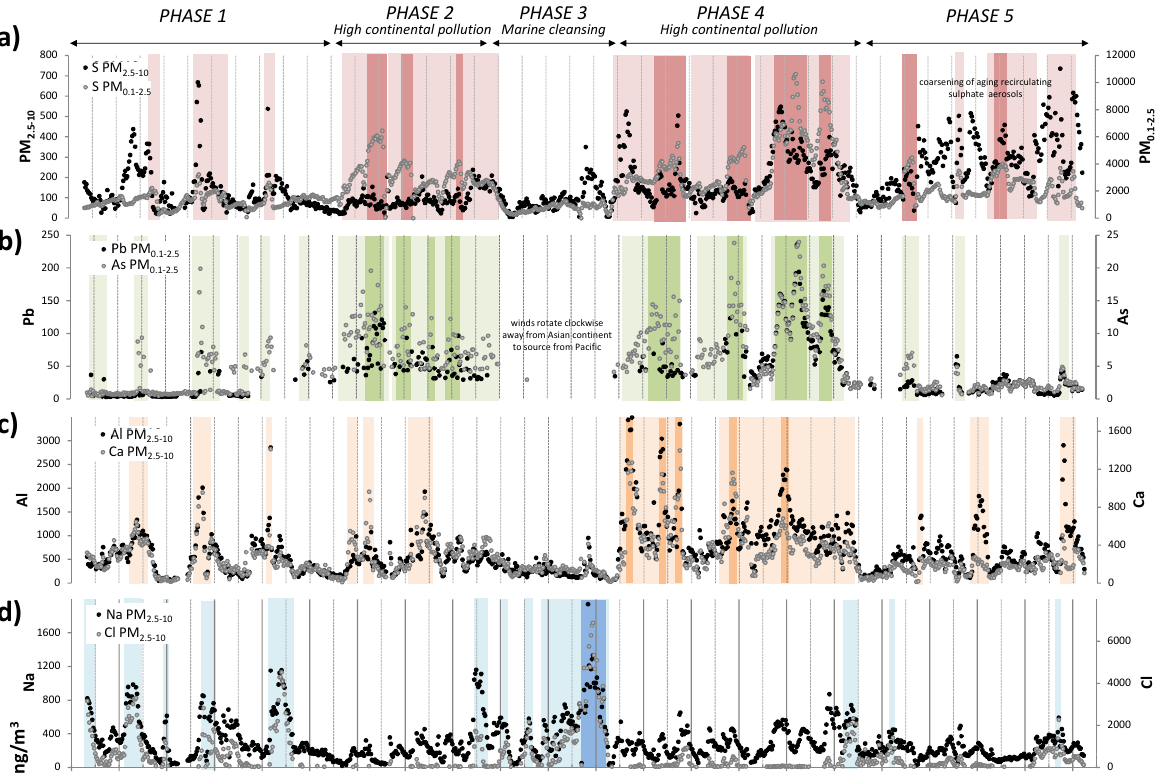
Fig. 4. Hourly selected elemental concentrations (ngm − 3 ) obtained with the Streaker sampler for the five air quality phases identified during the monitoring campaign, with coloured bands highlighting main episodes of continental pollution and advection of salty marine air across Kumamoto. (a) shows both coarse (PM 2 . 5 − 10 ) and fine (PM 0 . 1 − 2 . 5 ) sulphatic aerosol intrusions, (b) uses Pb and As to illustrate how toxic metallic aerosols accompany the sulphatic intrusions, (c) uses Al and Ca to reveal the rise and fall of Gobi Desert PM introduced by NW winds crossing NE China, and (d) uses Na and Cl to identify marine aerosol